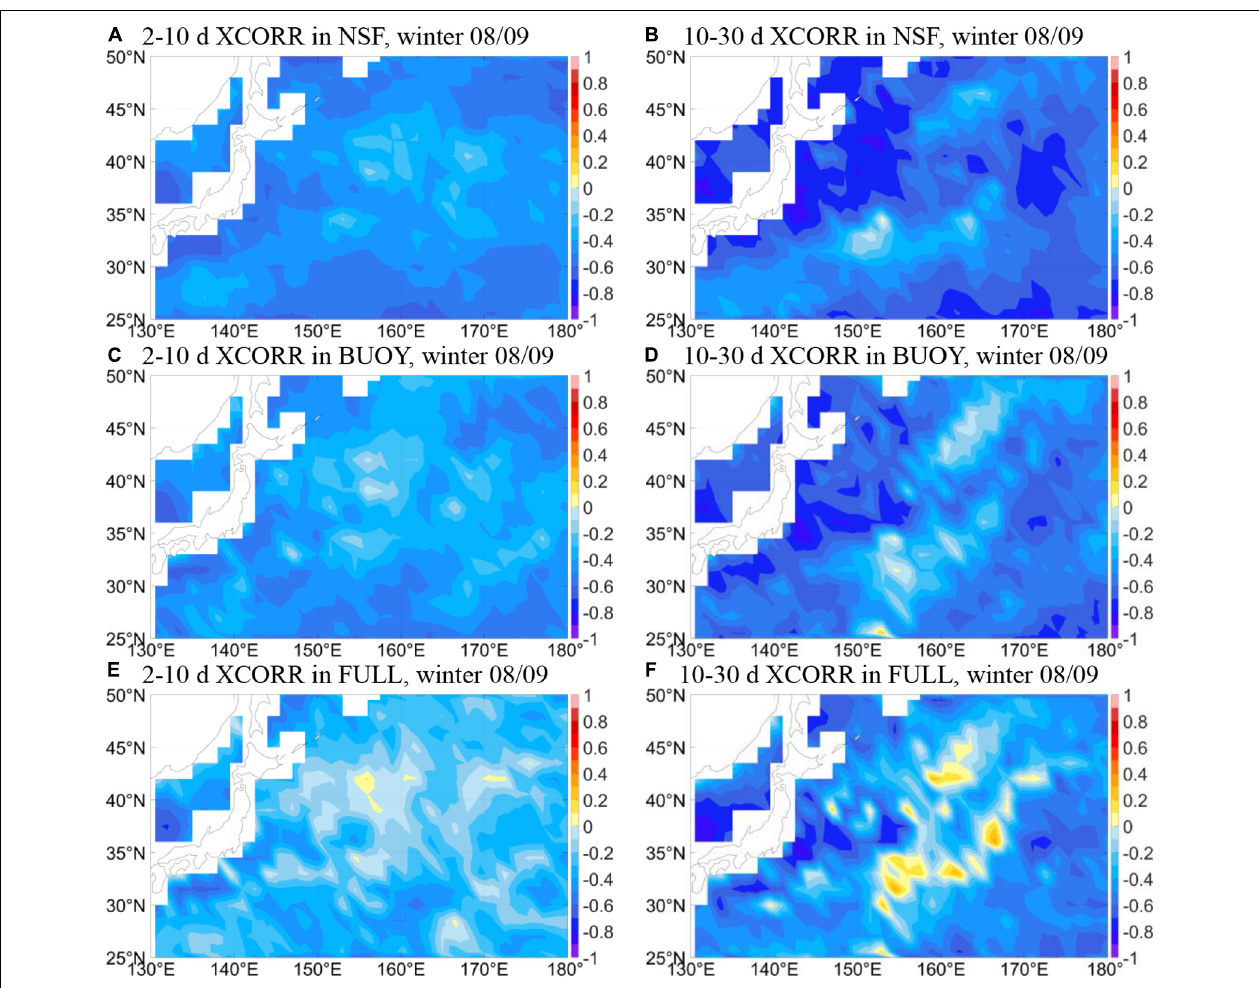
FIGURE 7 | Delayed correlation between net heat flux and SST in selected GOTM sensitivity experiments on (A,C,E) 2–10 days and (B,D,F) 10–30 days timescales. The time lag for the 2–10 days correlation is 1 day, and for the 10–30 days correlation it is 3 days. In these figures the correlations are statistically significant at the 95% level everywhere in the